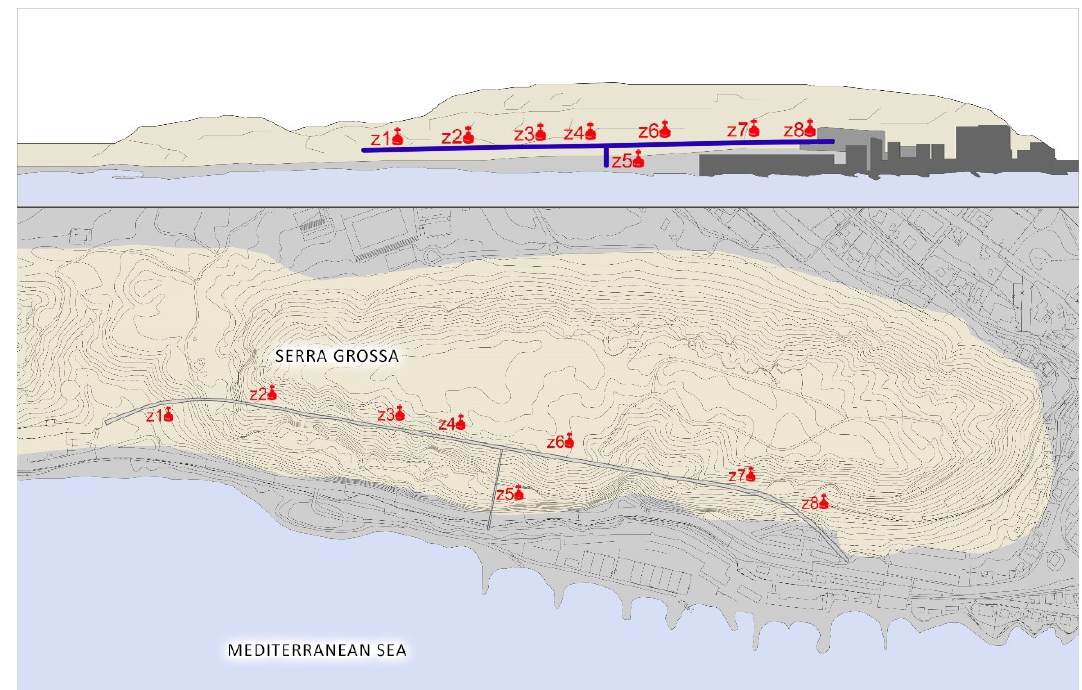
Figure 15. Top image of the tunnel elevation with the arrangement of the measuring elements. The Serra Grossa and the Albufera can be seen. Image below the tunnel floor with the disposition of the measuring